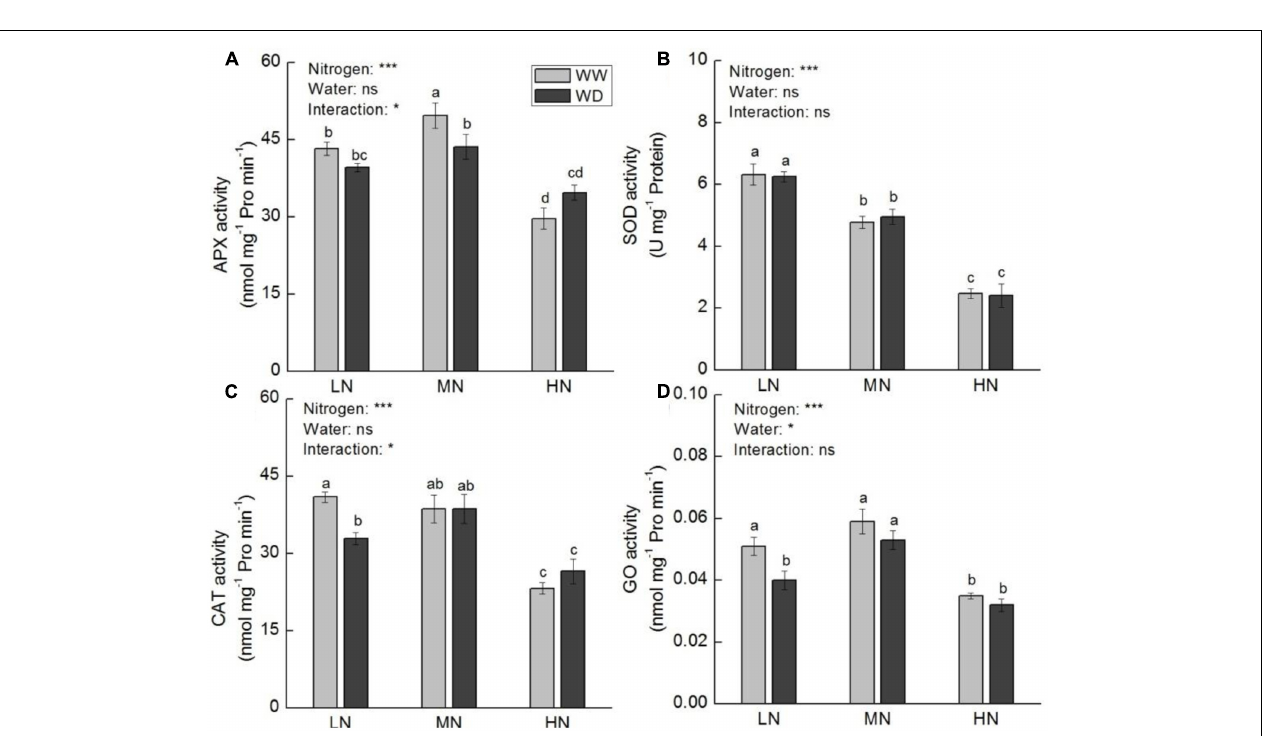
FIGURE 8 | Comparison in leaf lipid peroxidation (A) and hydrogen peroxide (B) in rice plants grown udner different nitrogen and water conditions. Data refers to mean ± SE ( n = 4). P -values of the two-way ANOVAs of nitrogen, water, and their interaction are indicated: ns, not significant; ∗ P < 0.05; ∗∗ P < 0.01; ∗∗∗ P < 0.001. Bars with the same letter are not significantly different by LSD test. WD, water deficit; WW, well-watered.